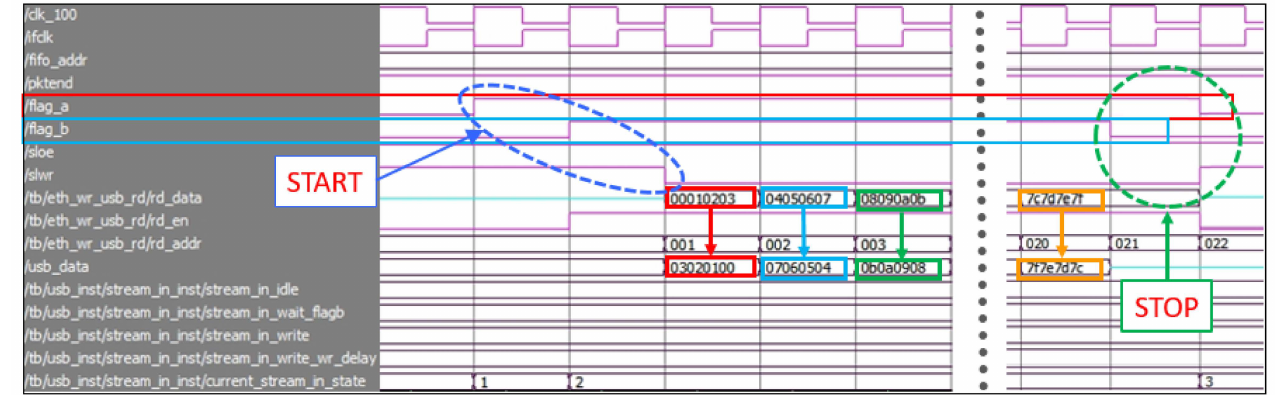
Figure 12. The stored serial data in SRAM and the transmitted USB data with control signals.